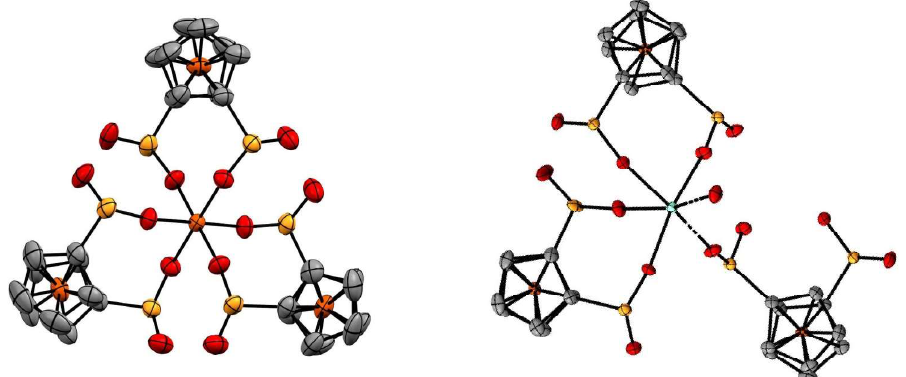
Comparison of ligand’s conformation in Fe(III)-based 1,1 (cid:48) -ferrocendiyl- bis(phenylphosphinate) complex ( left ) and Sm(III)-based 1,1 (cid:48) -ferrocendiyl-bis( H -phosphinate) 2D CP 2 ( right ). Phenyl rings and hydrogens are hidden for clarity.